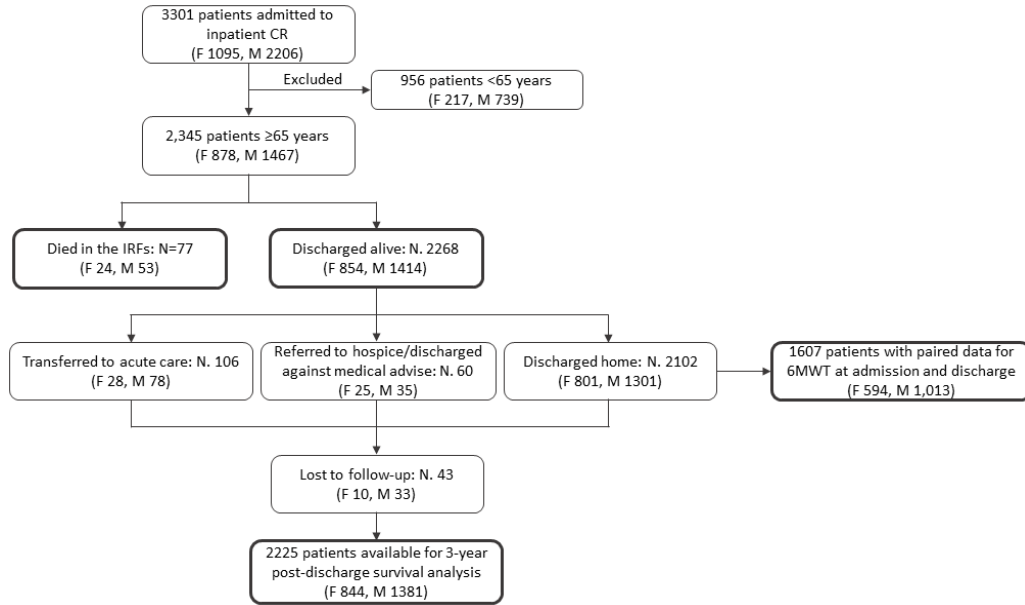
Figure 1. Flow-chart of the study. F denotes females, M males, CR cardiac rehabilitation, IRF inpatient rehabilitation facility, 6MWT 6-min walk test. Table 1 displays patient baseline characteristics stratified by sex. Table 1. Baseline characteristics.